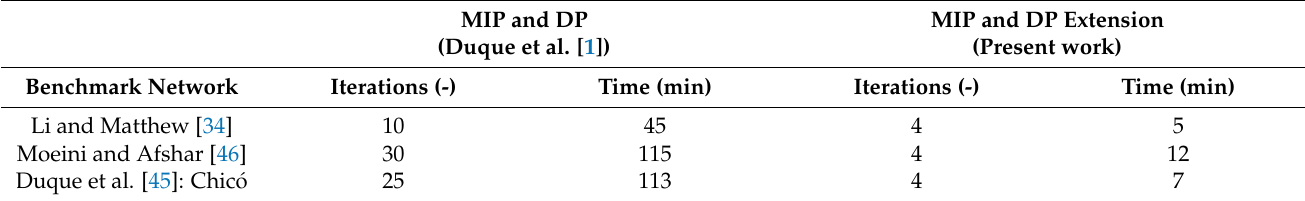
Table 9. Computational effort in MIP and DP, and MIP and DP